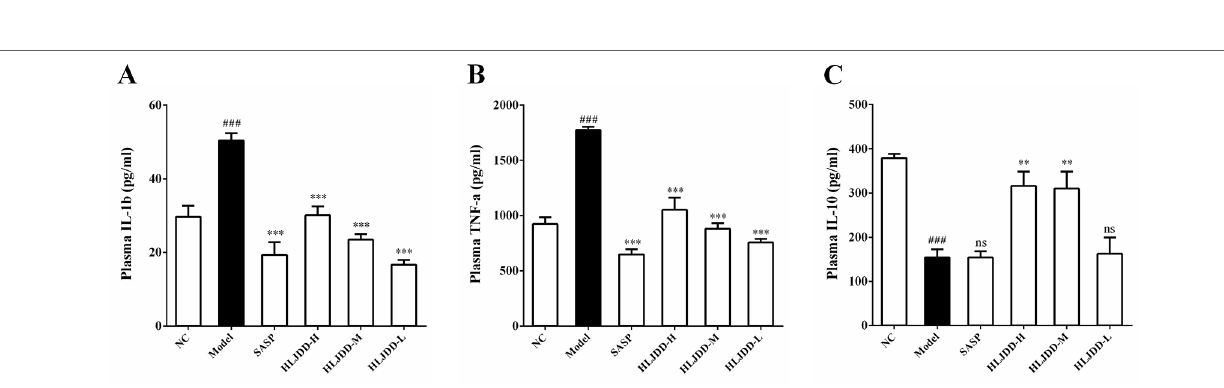
FIgURE 4 | HLJDD attenuates colonic pathological damage in acute UC mice. (A) Representative images showing colon pathologic damages with hematoxylin and eosin (H&E) staining, (200 × magnification). (B) Histological scores of colons. Data are expressed as the mean ± SD, n = 3 pre group. ### p < 0.001 vs. NC group; * p < 0.05, ** p < 0.01, *** p < 0.001 vs. model group.